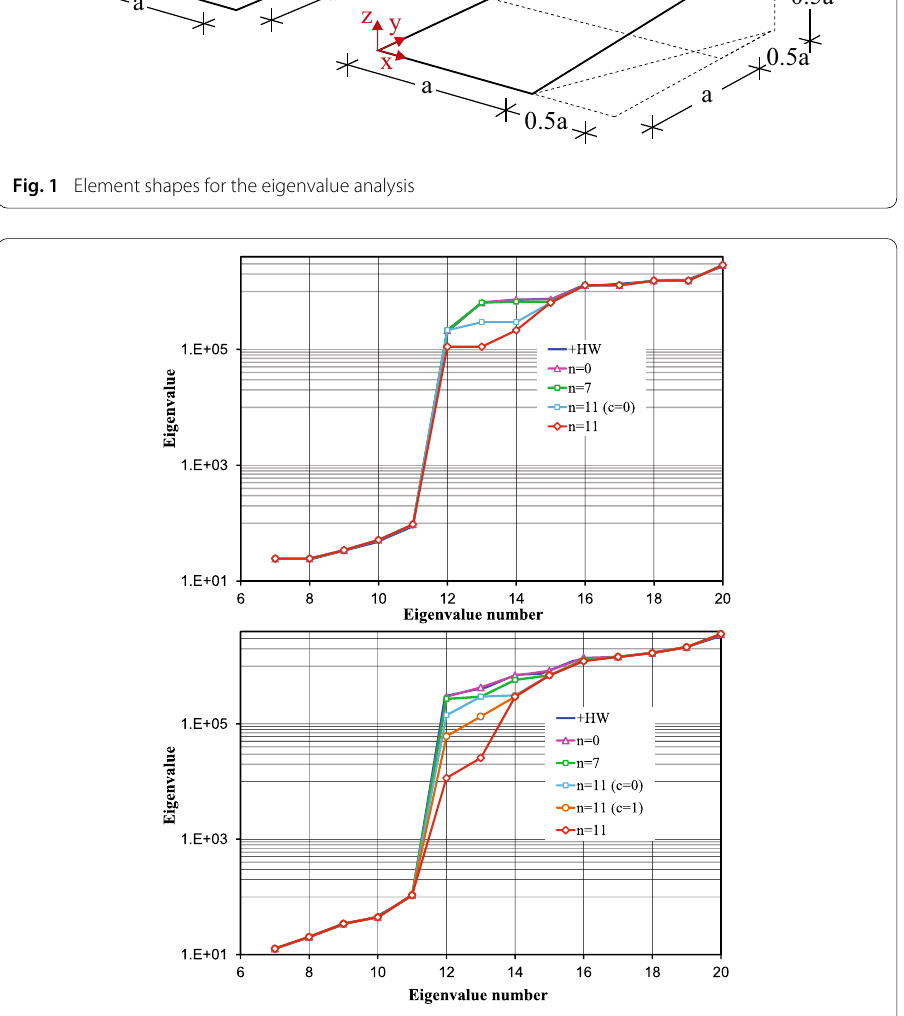
Fig. 2 Eigenvalues of the square element (top) and the distorted element (bottom) Table1 Eigenmodes for eigenvalues 11–15 of the square element